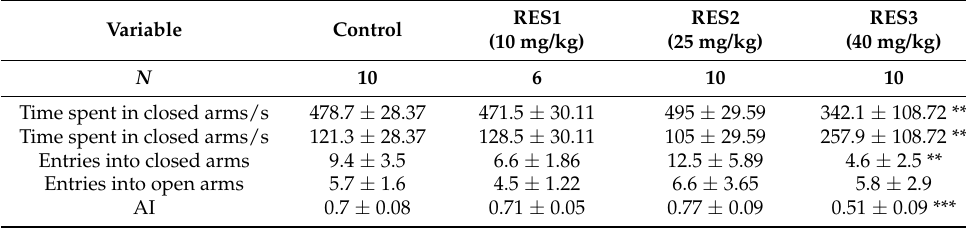
Table 1. Effect of RES treatment on EPM test